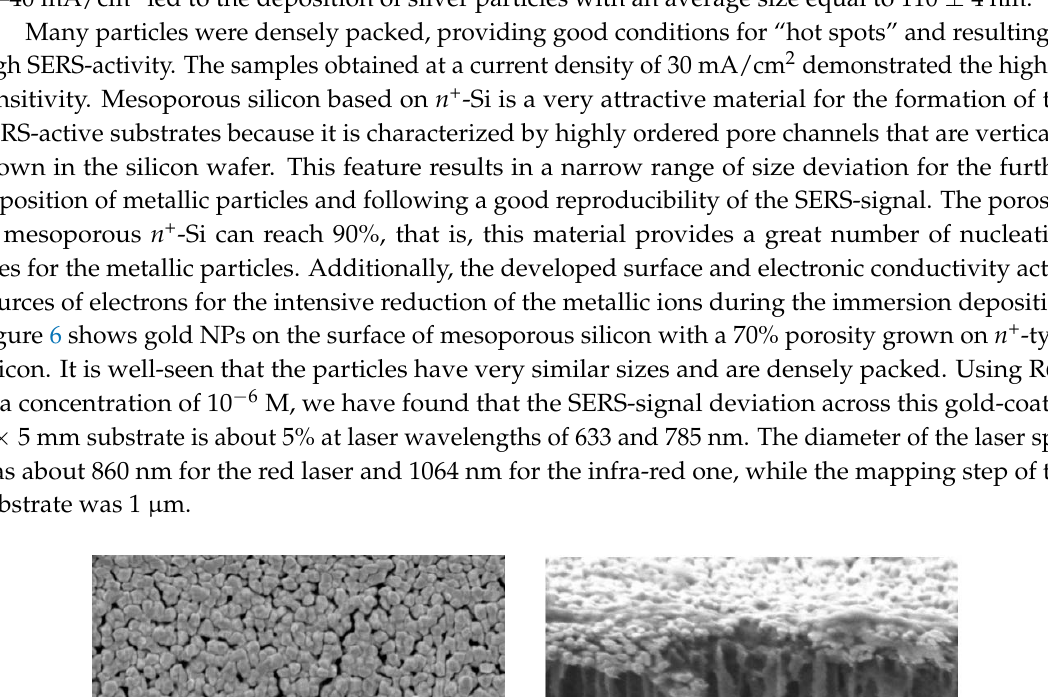
Figure 5. The SEM top views of porous silicon coated with silver for 10 min from the solutions with silver nitrate concentration of ( a ) 0.1 M and ( b ) 0.01 M.